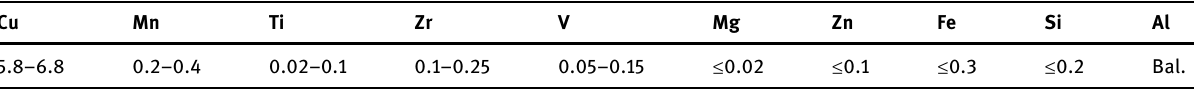
Table 1: Chemical composition ( wt% ) of the 2219 Al – Cu alloy rings